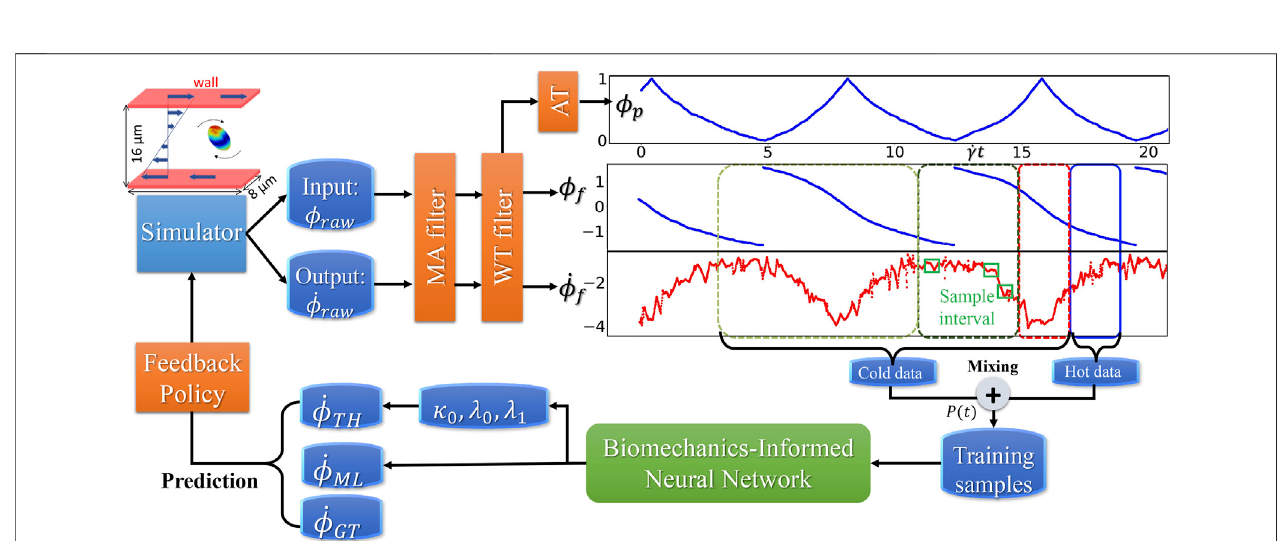
FIGURE 3 | Speed distributions for representative rigid and deformable platelets at 100 dyne/cm 2 .